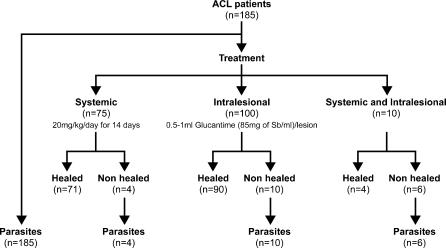
Treatment Outcome and Parasite IsolationParasites were isolated from 185 patients with suspected ACL prior to treatment. Patients were included in three forks of treatment, and 20 patients did not respond to therapy. Parasites from these nonresponders were also isolated.